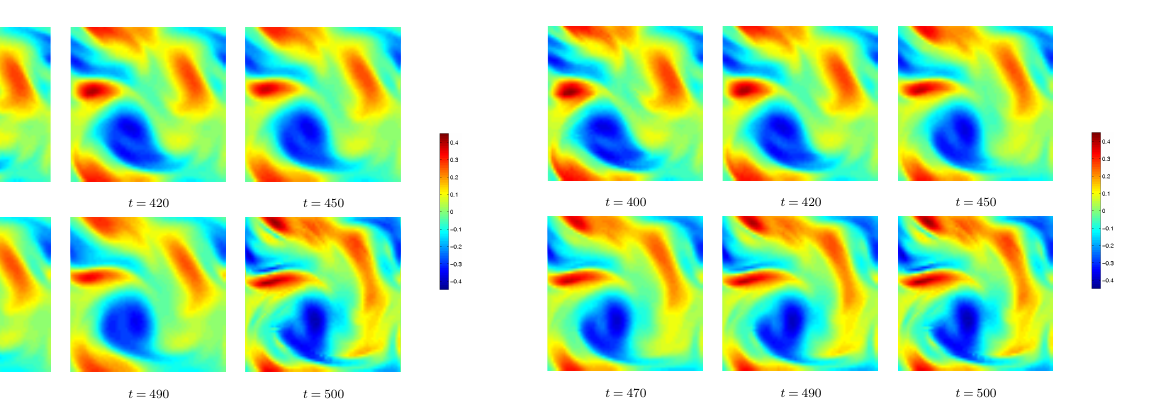
Figure 10. Smoothing result with the proposed method. Estimated Fig.10: Smoothing result with the proposed method. Estimated mean vorticity maps for different times t betweenobservationtimes t =400 and t =500 . mean vorticity maps for different times t between observation times t = 400 and t =